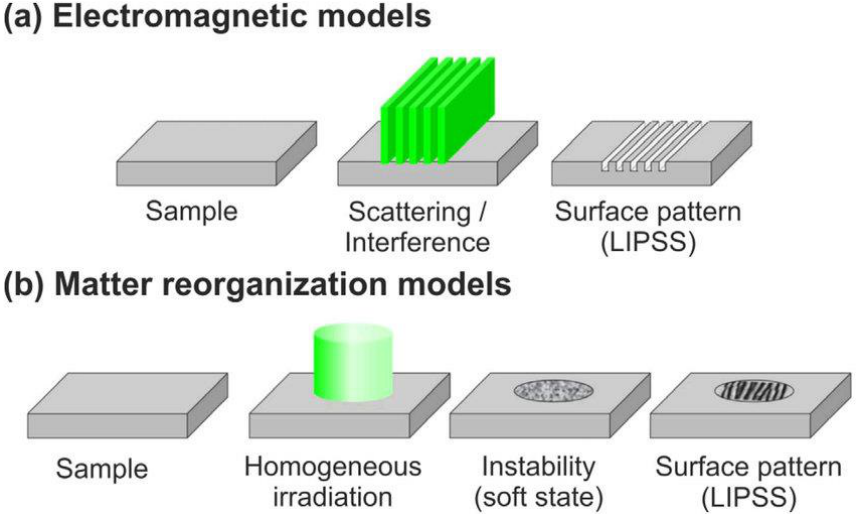
Figure 2. Ref. [42] Fundamental processes occur during LIPSS formation according to ( a ) electromagnetic models and ( b ) matter reorganization models. The laser irradiation is marked in green.